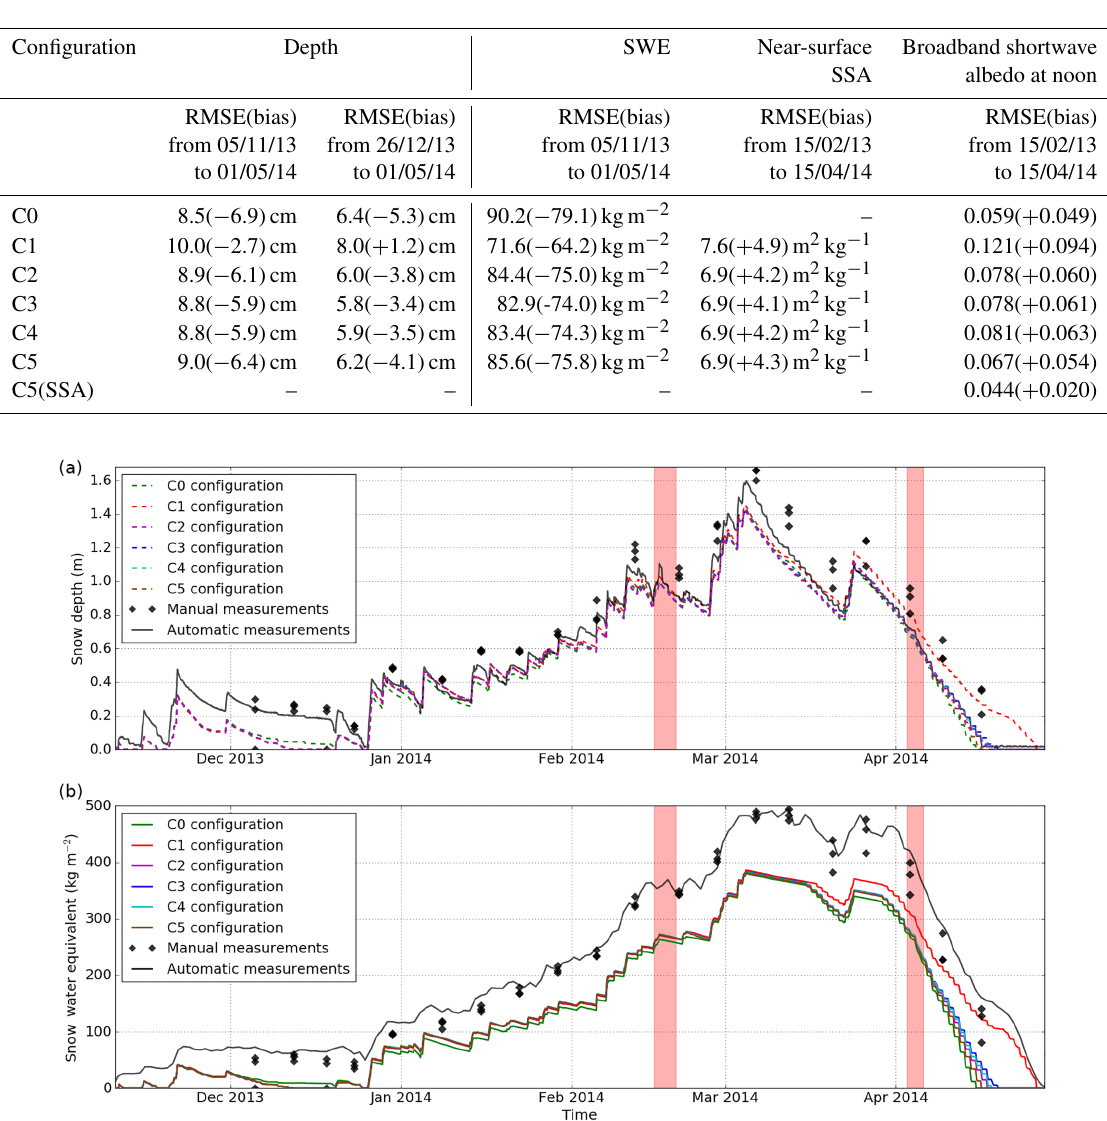
Figure 3. Measured and simulated total snow depth (a) and total SWE (b) at the Col de Porte along the 2013–2014 snow year. The two major Saharan dust events are represented by the red